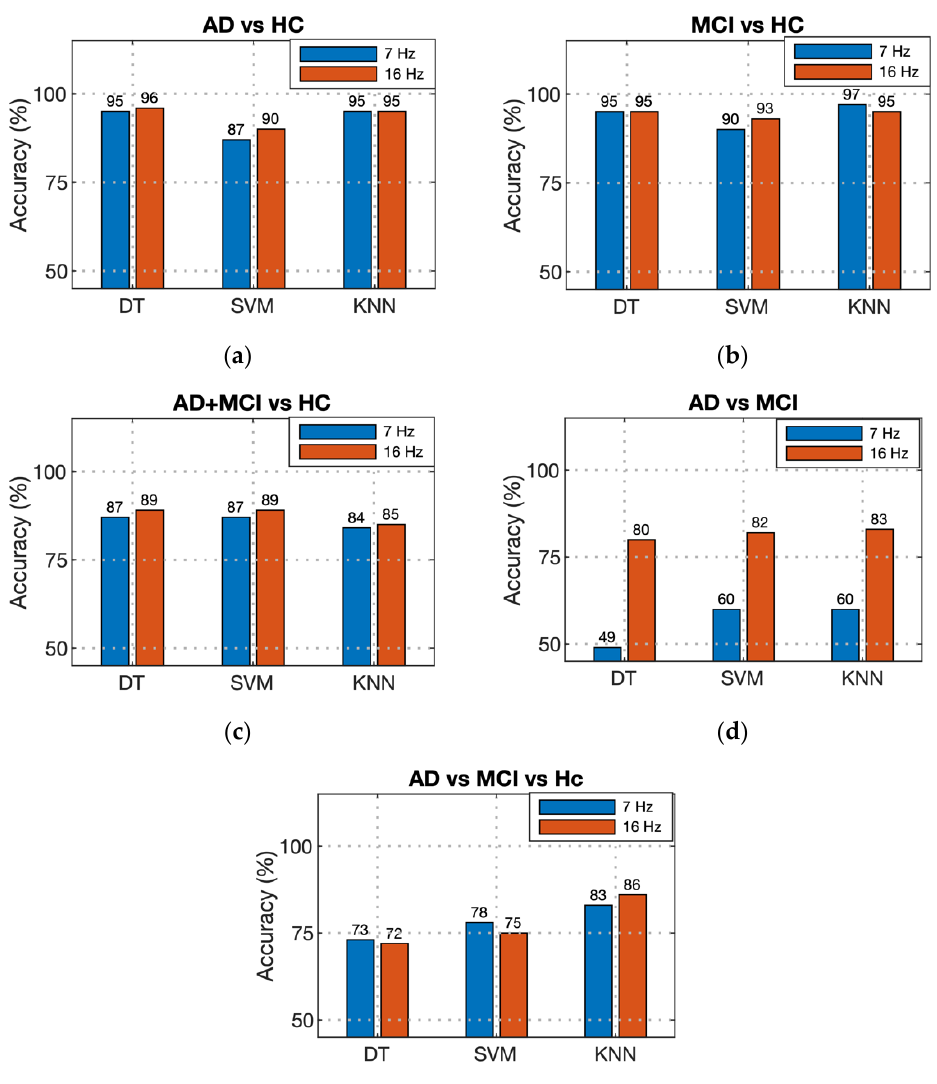
Figure 5. Each subfigure displays the comparison between the three classification methods: decision tree (DT), support vector machine (SVM), K-nearest neighbors (KNN) in the different problems: ( a ) AD vs. HC, ( b ) AD vs. MCI, ( c ) MCI vs. HC, ( d ) AD + MCI vs. HC, and ( e ) AD vs. MCI vs. HC. Furthermore, all the subfigures show the accuracy results achieved in percentages at f cut = 7 Hz in the blue column and f cut = 16 Hz in the red column.